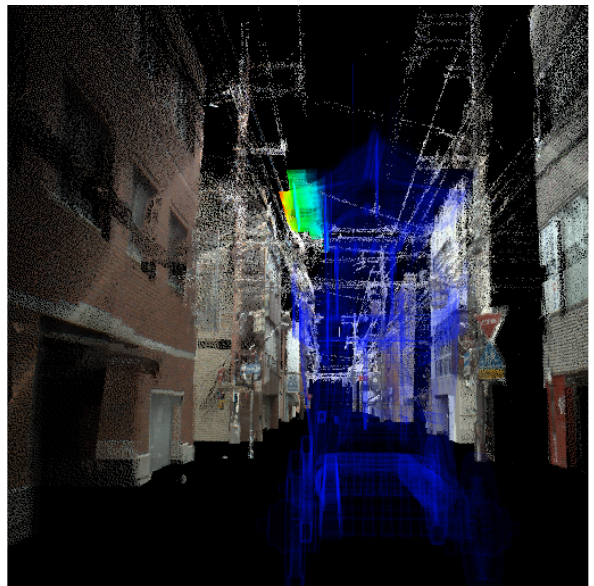
Figure 13. See-through visualization of high collision risk areas in a case that no collision exists. The total number of points used for the visualization is 7 . 8 × 10 ! , and the rendering speed is 15.64 fps.